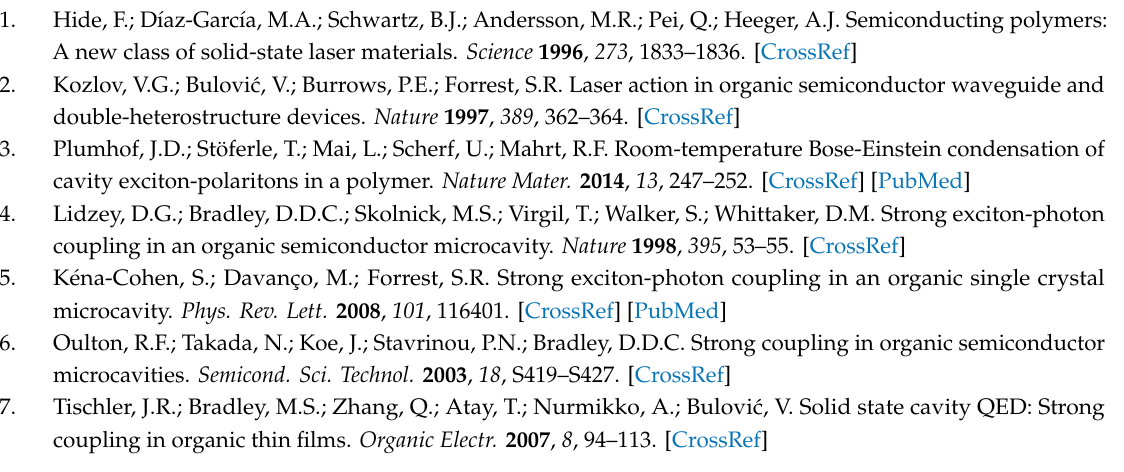
Mie Theory calculations for coated spheres; Figure S1: Validity of Mie vs. Rayleigh scattering and FDTD simulations; Figure S2: Variation of resonance linewidth for core-shell structures with a single Lorentzian oscillator shell; Figure S3: Scattering e ffi ciency calculated using Mie theory for a bare Ag sphere embedded in a uniform dielectric medium with varying real relative permittivity; Figure S4: Variation of oscillator strength for core-shell structures with single Lorentzian oscillator shell (non-normalized data and shell absorption); Figure S5: Normalized scattering spectra for variation of high-frequency relative permittivity for core-shell structures with a single Lorentzian oscillator shell; Figure S6: Permittivity and scattering spectra for varying number of Lorentzian oscillators using simple summation of oscillators model (Franck-Condon factor = 1); Figure S7: Non-normalized scattering spectra for Ag nanorod core-shell structures with permittivies for common conjugated